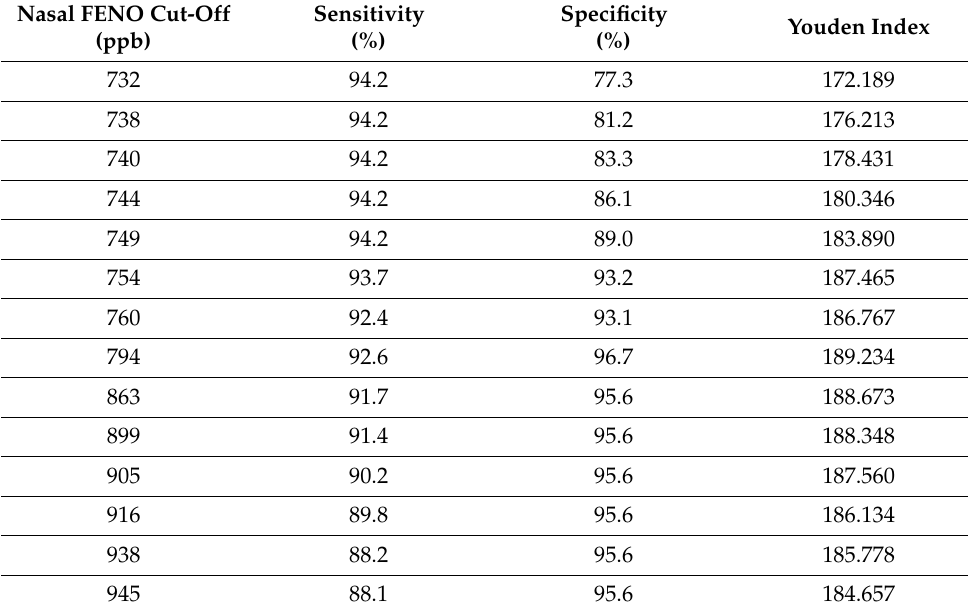
Table 4. Cut-off nasal FENO with corresponding AR diagnosis sensitivity and specificity.